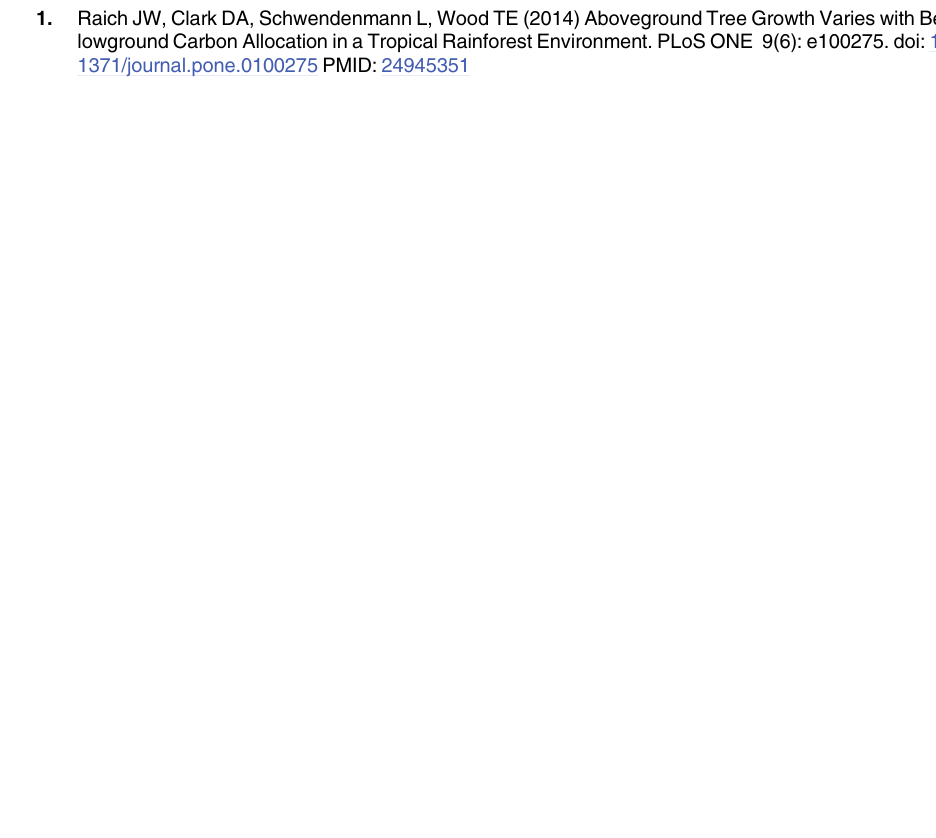
S2 Table. Equations used to estimate per-tree aboveground biomass and leaf area in the plantations. Only trees (cid:1) 10 cm diameter at breast height were included in biomass and tree growth calculations for this study. For total aboveground biomass (TAB, kg) the independent variable was d 2 h , with d = tree diameter at breast height (m) and h = total tree height (m). For total tree leaf area (m 2 ) the independent variable was d 2 (cm 2